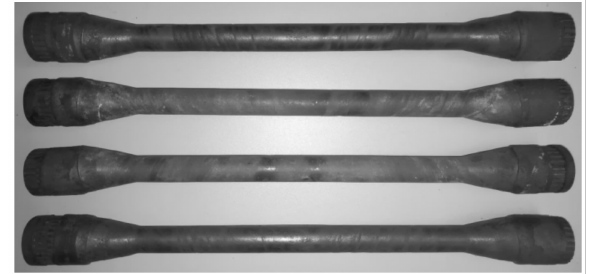
Figure 6. Examples of parts rolled in the CWR calibration test.